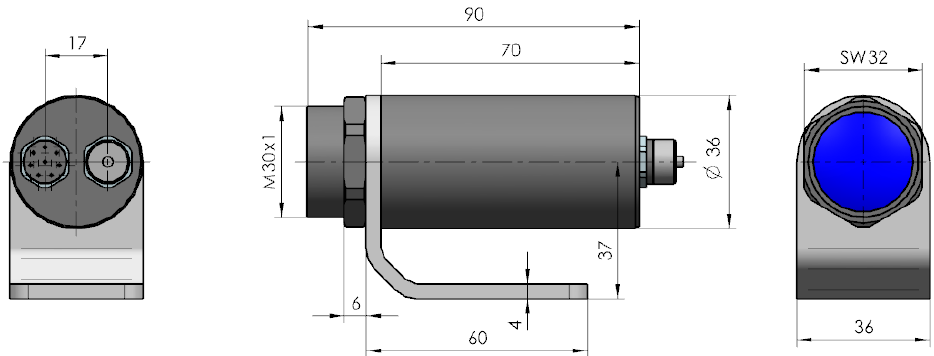
Figure 11. Dimensions of the Optris Xi 80 thermal imaging camera.